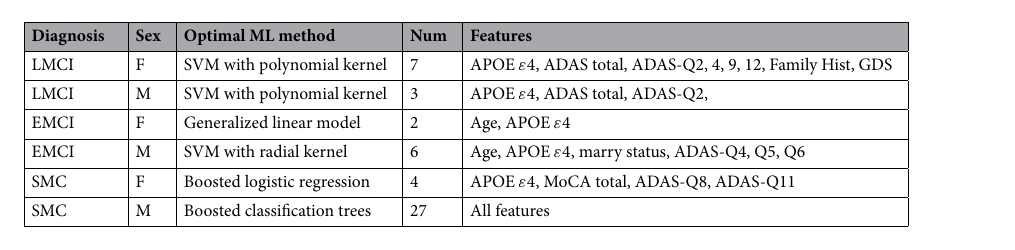
Table 3. The optimal ML model for each